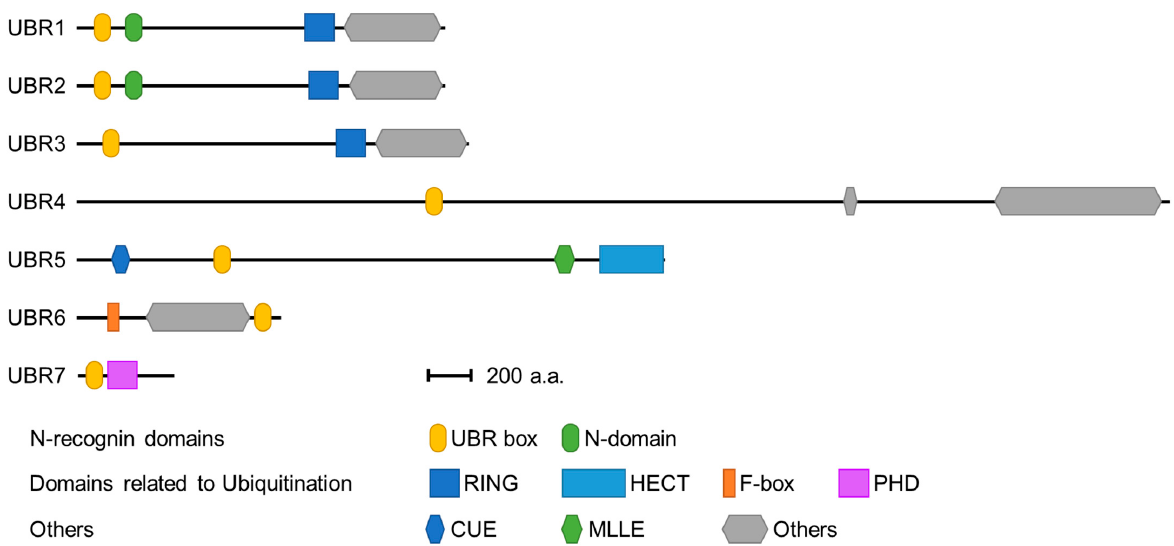
Figure 2. Domains of the UBR box protein family. All UBR proteins have a UBR box (yellow ellipse) to recognize N-degrons, and this UBR box is the signature of the UBR family. UBR1 and UBR2 also have an N-domain (green ellipse) that recognizes the type 2 N-degrons. In addition, these UBR proteins have a RING (navy blue square), HECT (blue square), F-box (orange box), or PHD domain (purple box) for E2 binding or ubiquitin conjugation. Other domains include the CUE domain, which recognizes ubiquitin, and the MLLE domain, known to regulate the catalytic activity of HECT.